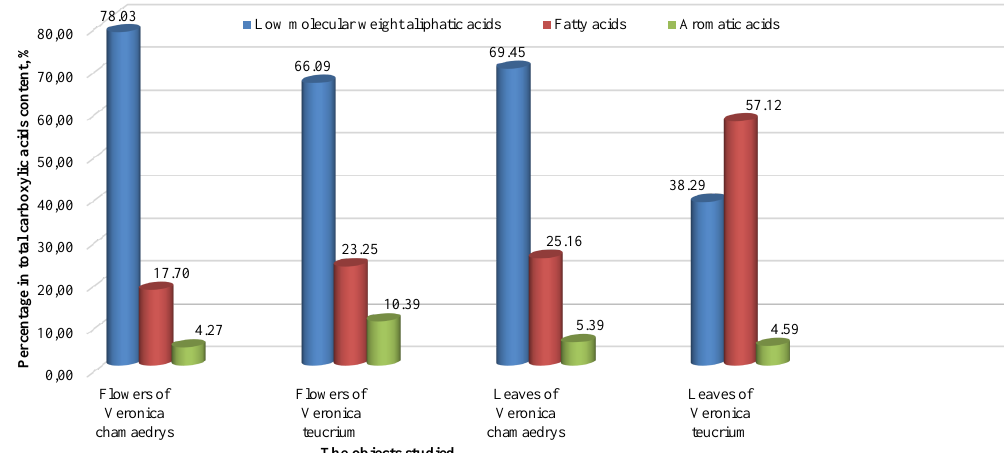
Fig. 6. The composition of carboxylic acids of flowers and leaves of Veronica chamaedrys and flowers and leaves of Veronica